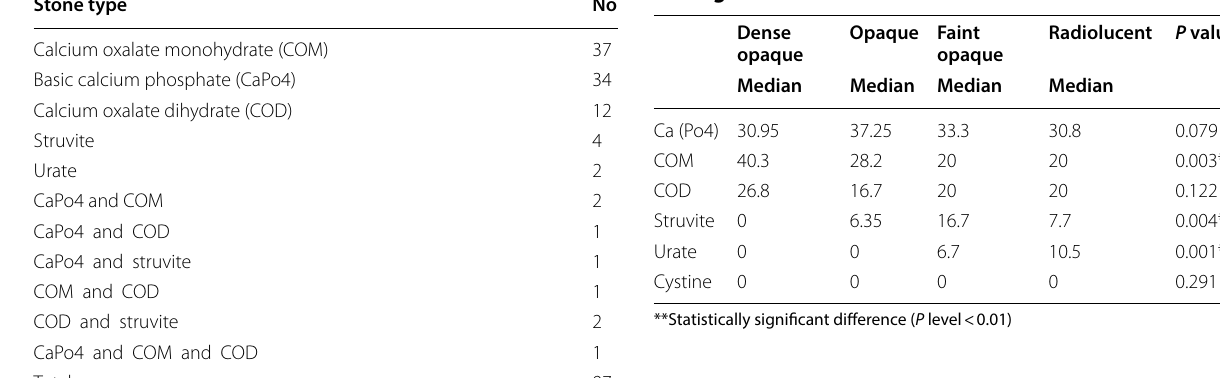
Table 3 Relation between type of the stone and its KUB